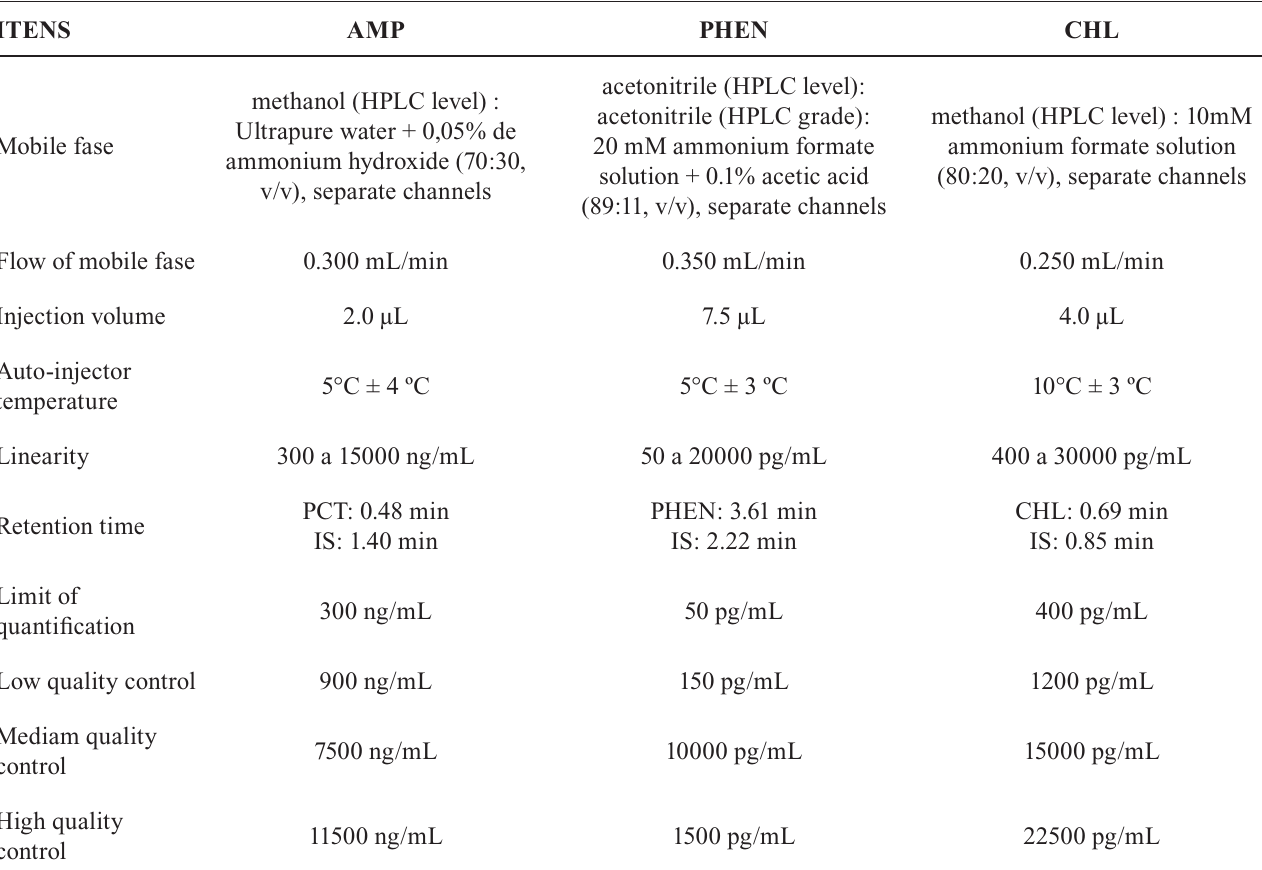
TABLE I - Bioanalytical methods for the drugs acetaminophen, phenylephrine and chlorpheniramine